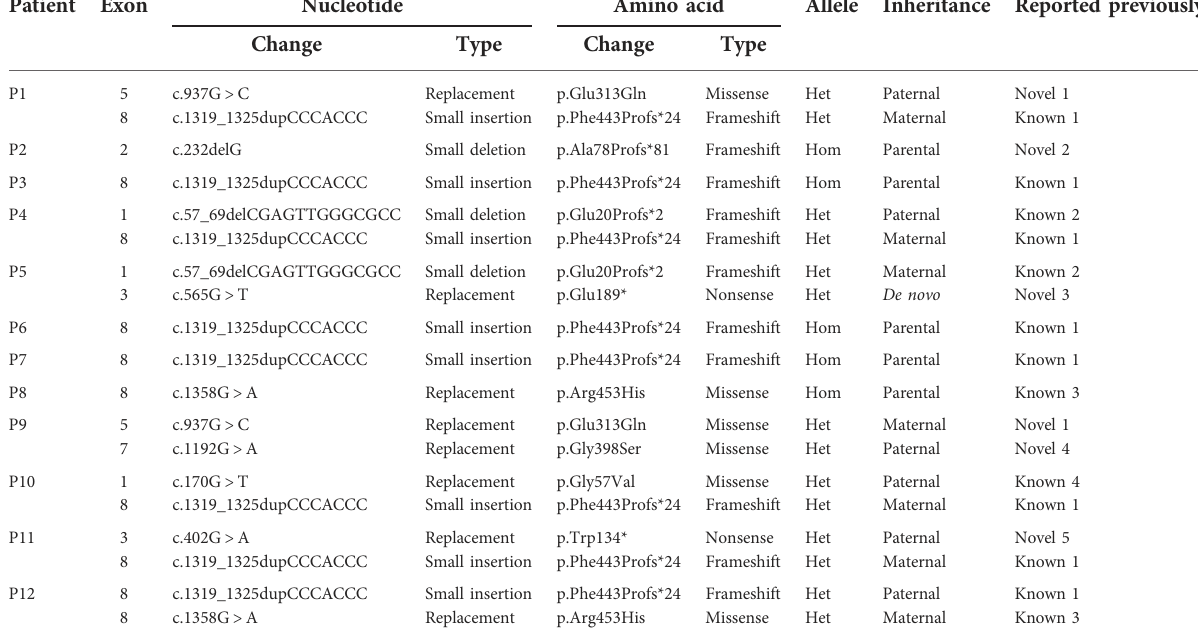
TABLE 3 Deleterious CYP27B1 variants identi fi ed in 12 VDDR1A children. Patient